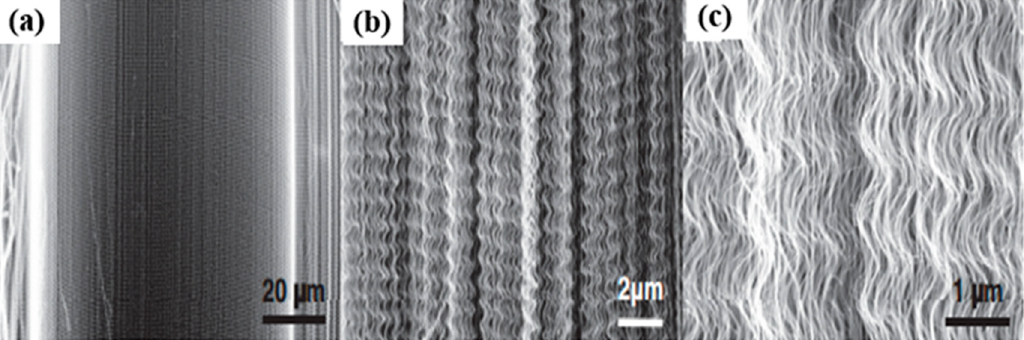
Figure 8. SEM images of a MWNT array with wavy structures at various magnifications ( a – c ). Reproduced with permission from [84]. Copyright Elsevier, 2009.